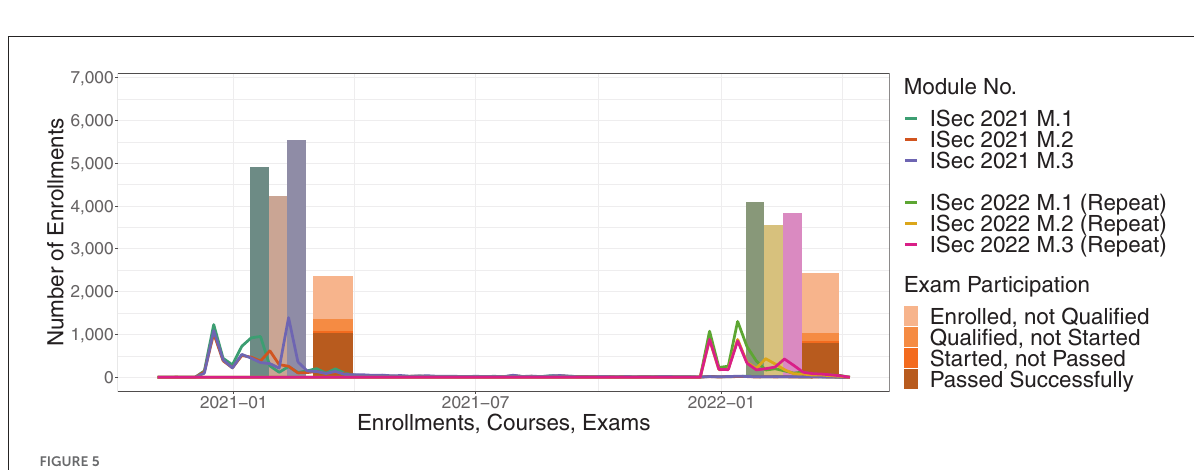
FIGURE5 ISec 2021 and ISec 2022 with both exam opportunities and the required modules. The lines show the weekly enrollments. The first three bars show the original course periods and the total enrollments in each of the course modules. The orange bars show the final exams including their